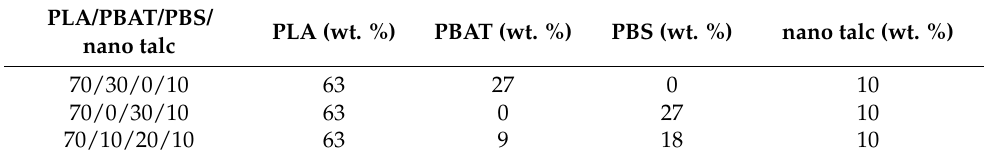
Table 1. Compositions of binary and ternary blend composites from PLA/PBAT/PBS/nano talc.